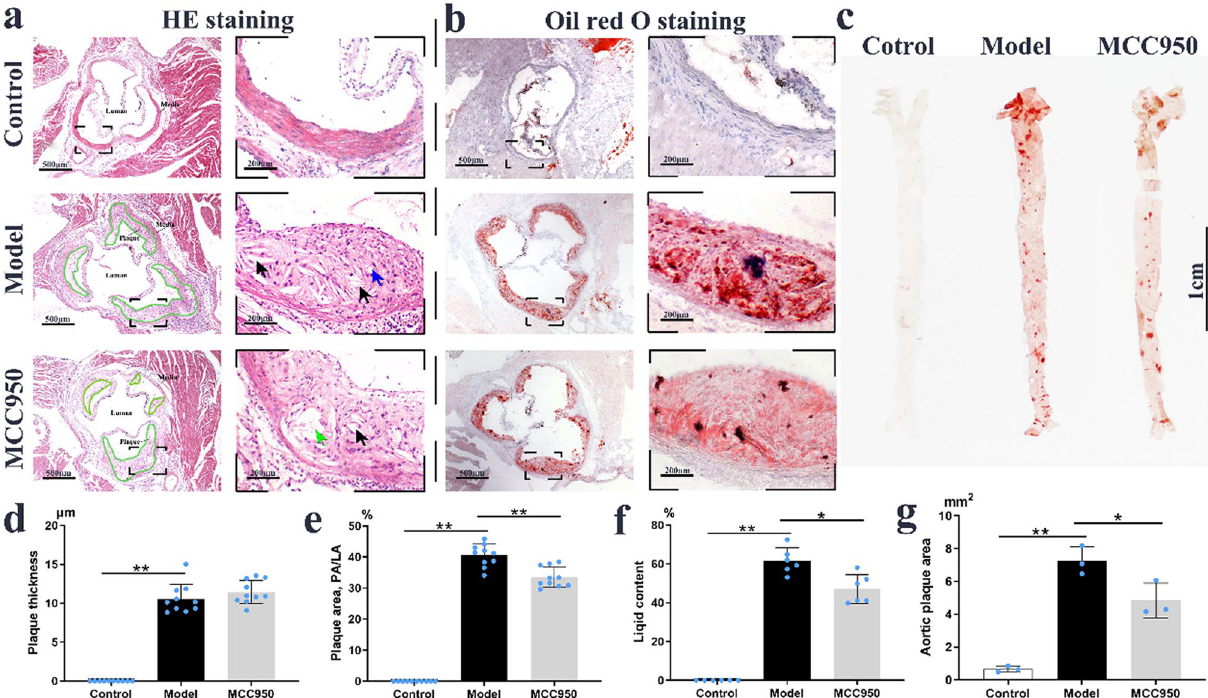
Figure 1. MCC950 reduced atherosclerotic plaque formation. Representative images of aortic roots with HE staining ( a ), Oil Red O staining ( b ) and the whole aorta with Oil Red O staining ( c ) were shown. The arrows indicated foam cell (blue), cholesterol crystal (black) and lipid core (green). The plaque thickness ( d , n = 10/ group), plaque area (PA/LA; e , n = 10/group), lipid content ( f , n = 6/group) and aortic plaque area ( g , n = 3/ group) were quantitatively analysed. The original magnification was ×40 (scale bar = 500 μm), while the high magnification was ×100 (scale bar = 200 μm). Data were expressed as mean ± SD. * P < 0.05 was considered significant, ** P <